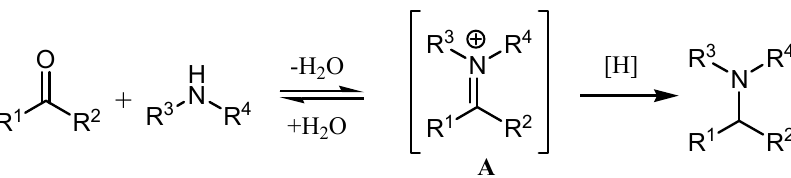
Scheme 1. Direct reductive